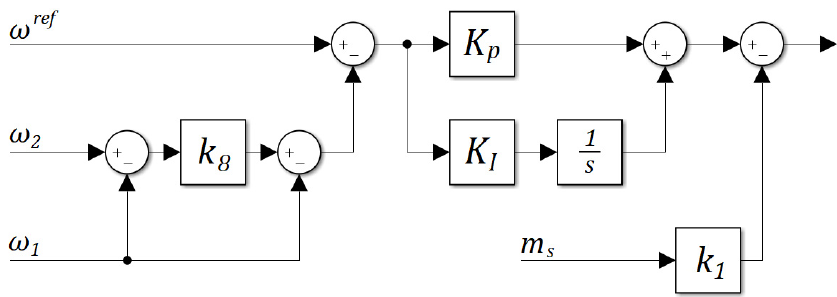
Figure 1. PI controller structure with two additional feedbacks.